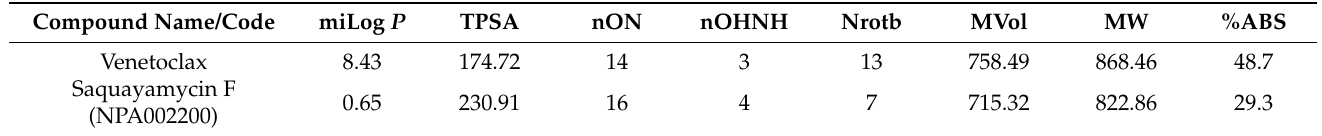
Table 3. Predicted physiochemical properties of saquayamycin F (NPA002200) and venetoclax as Bcl-2